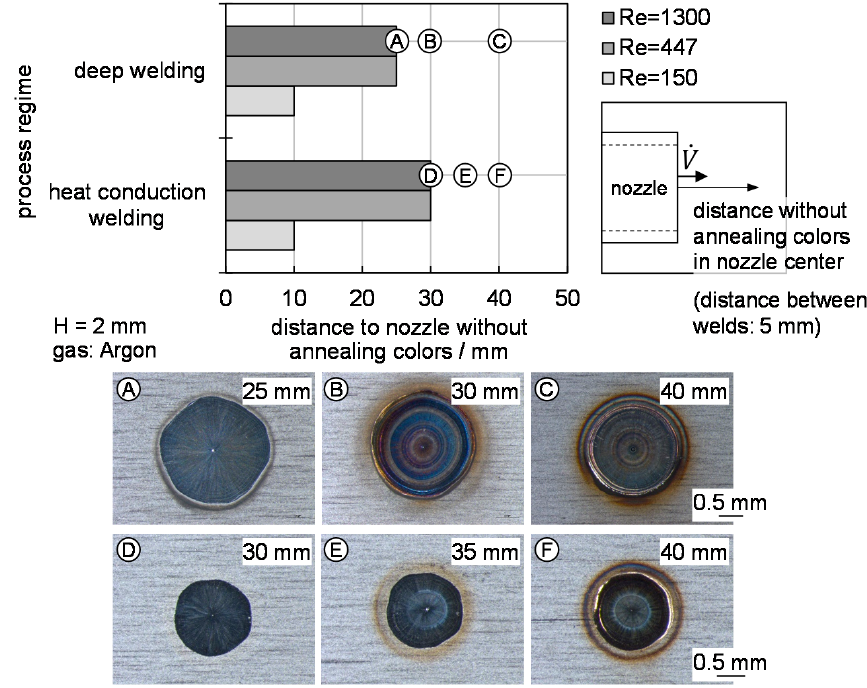
Figure 9. Occurrence of annealing colors depending on distance to orifice for deep penetration welding and heat conduction welding.